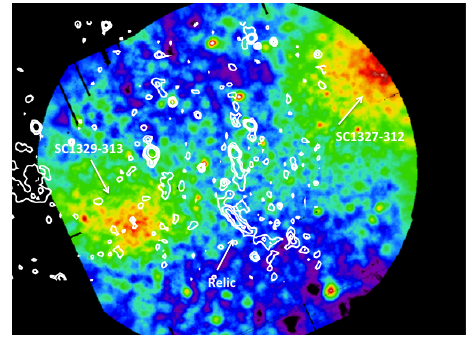
Figure 4. The same contours at 325 MHz as in Figures 2 and 3, overlaid on the XMM–Newton emission of the two SC